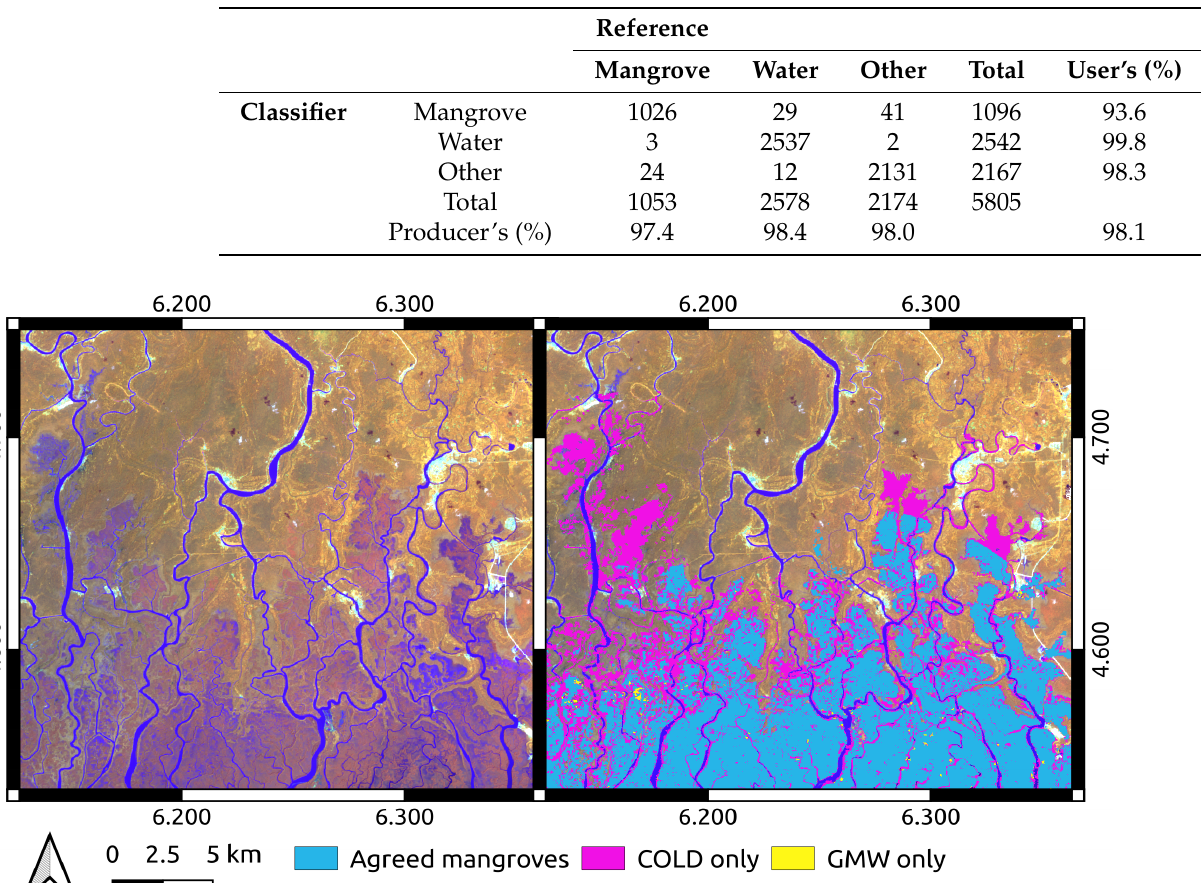
Table 4. Results of spatiotemporal accuracy assessment for the Niger Delta.